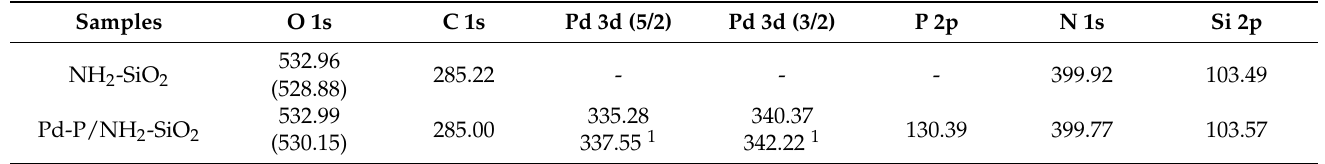
Table 3. Binding energies (eV) of the core levels in XPS